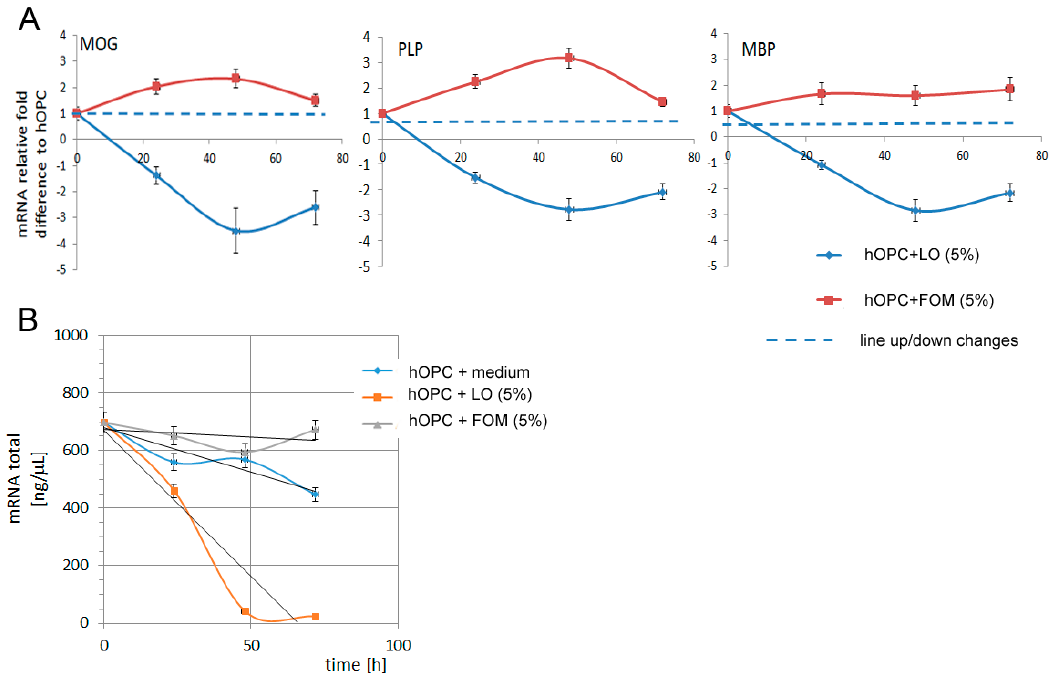
Figure 3. ( A ) Quantitative analysis of myelin protein mRNA expression confirmed that hOPCs supplemented with FOM contrary to LO were characterized by increased MOG, PLP, and MBP synthesis during maturation into OLs. ( B ) Increased global mRNA levels in hOPCs supplemented with FOM. Data are presented as means ± SD from four independent experiments.